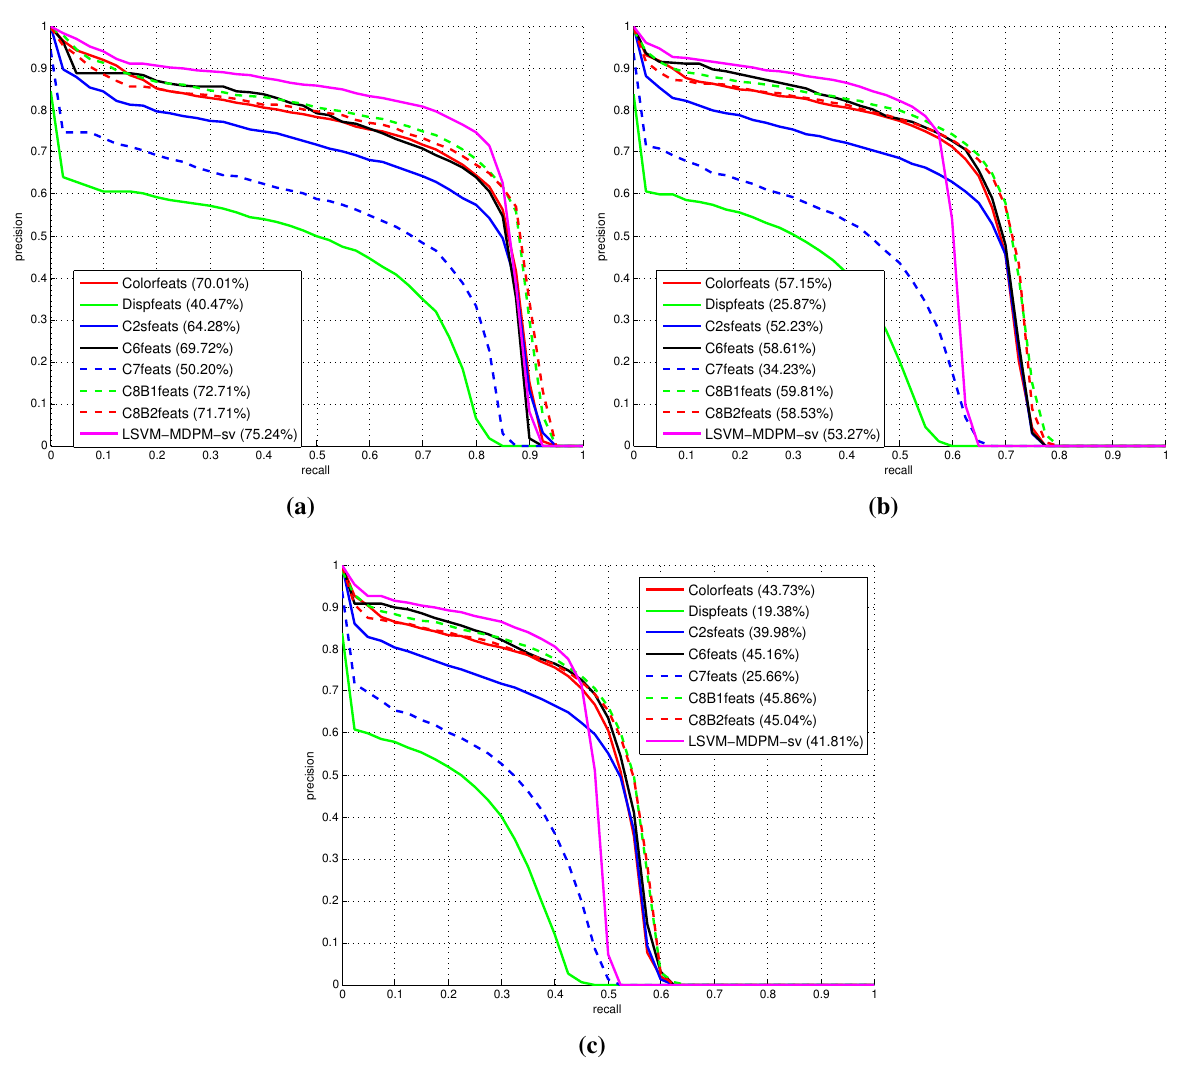
Figure 11. Comparison of the 3D-aware features average orientation similarity (AOS) performance for the class ‘car’. ( a ) Easy; ( b ) moderate; ( c )